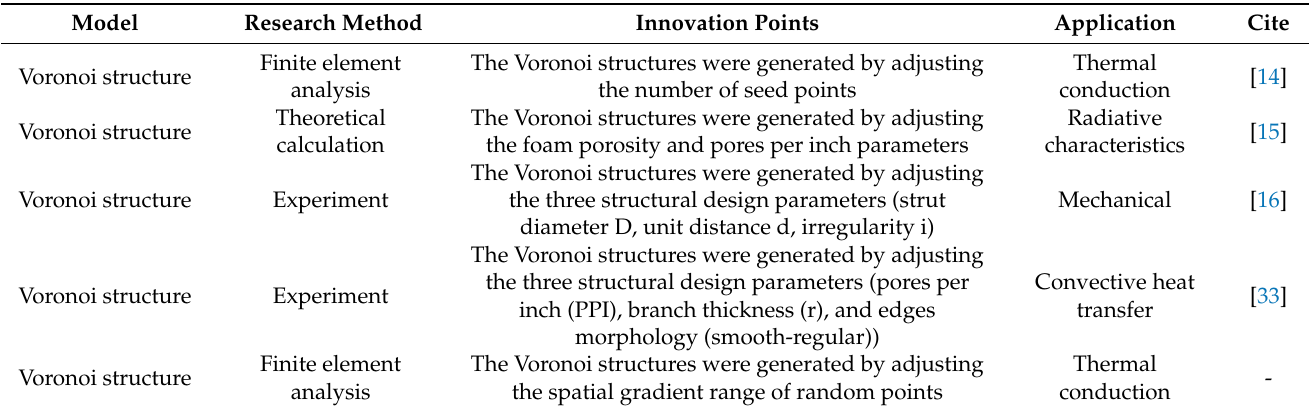
Table 1. Comparison of design innovation points of Voronoi